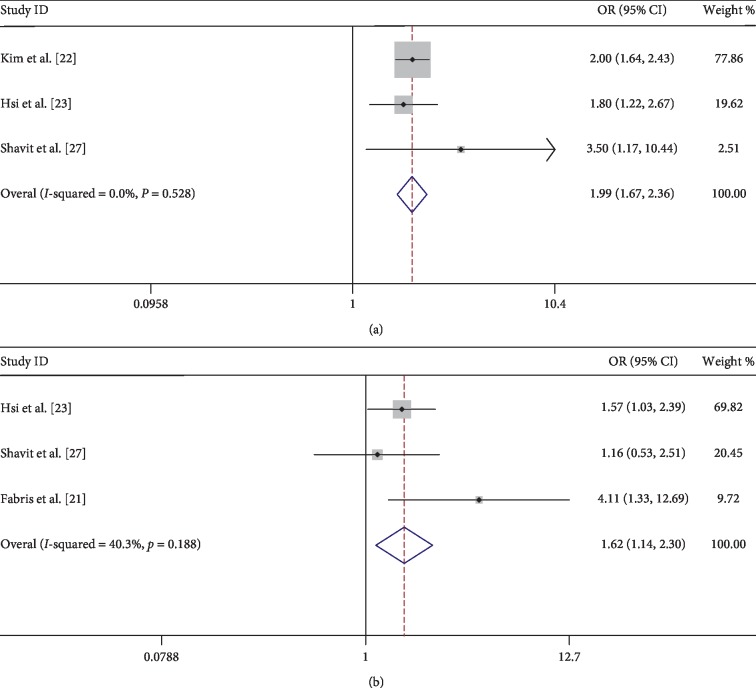
(a) Forest of comparison: renal calculi versus without renal calculi and event: moderate or severe arteriosclerosis. (b) Forest of comparison: recurrent renal calculi versus without renal calculi and event: arteriosclerosis. OR: odds ratio; CI: confidence interval.